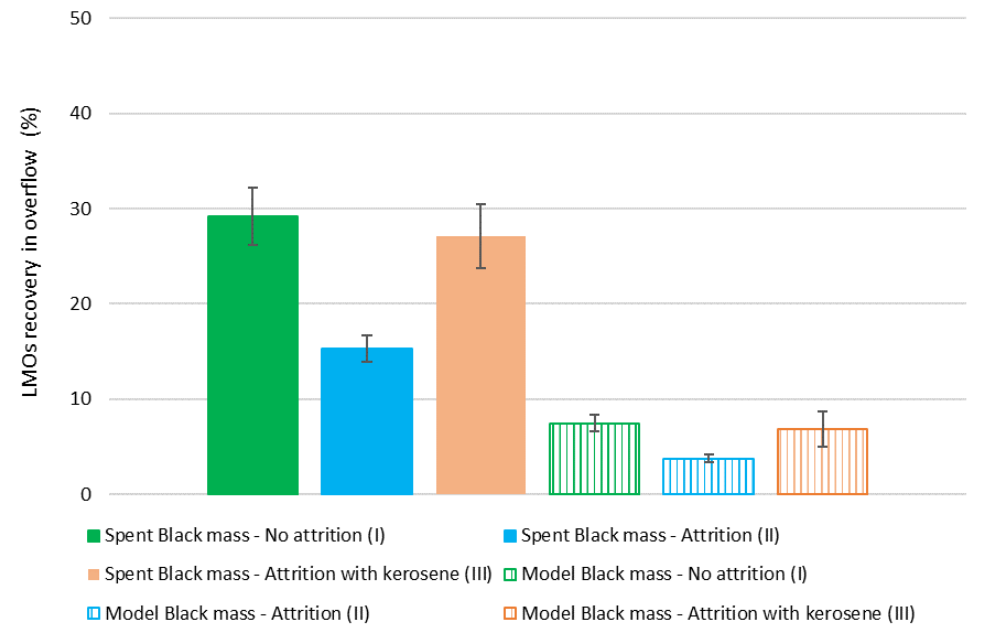
Figure 7. Recoveries of LMOs (including Co, Ni, and Mn elements) from spent black mass and model black mass with the different flotation flows: no attrition pre-treatment, with attrition pre-treatment, and attrition pre-treatment with kerosene. The results are average values of four experiments and the error bars represent an interval confidence of 90%.